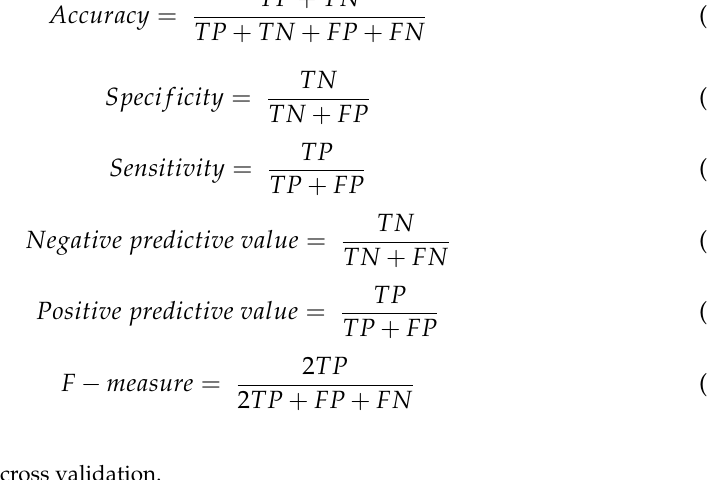
Table 2. Results of 5-fold cross